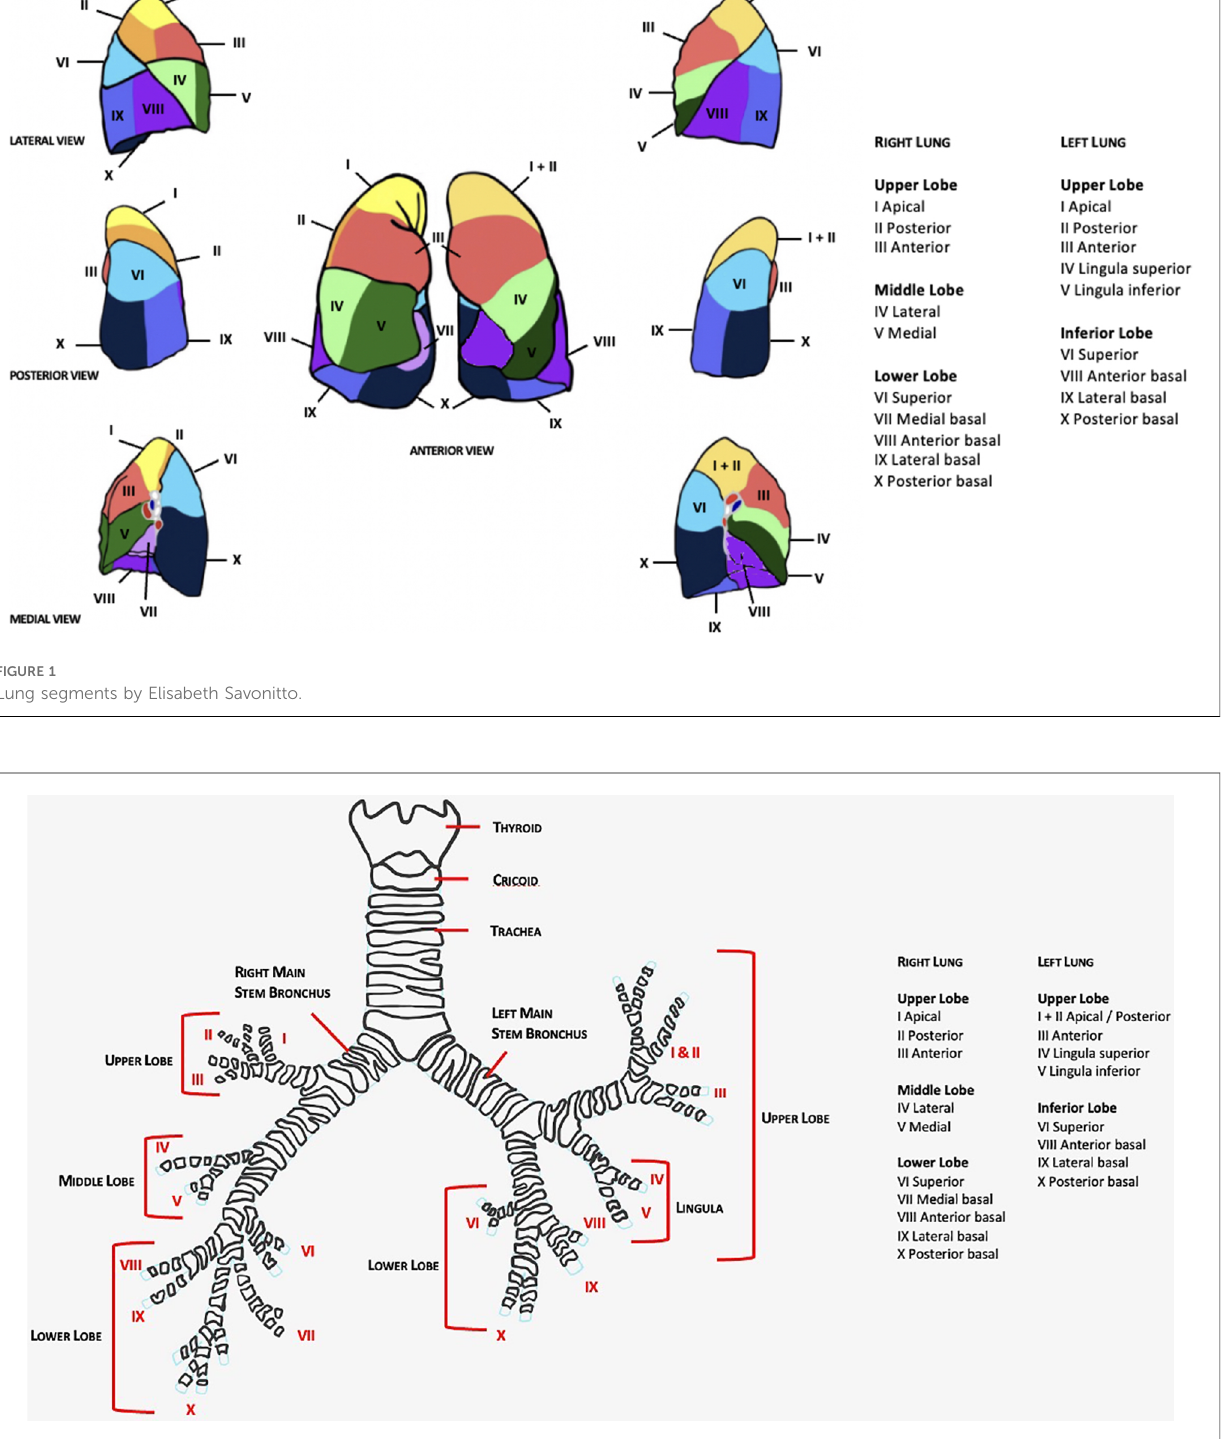
FIGURE 2 Bronchial tree by Elisabeth